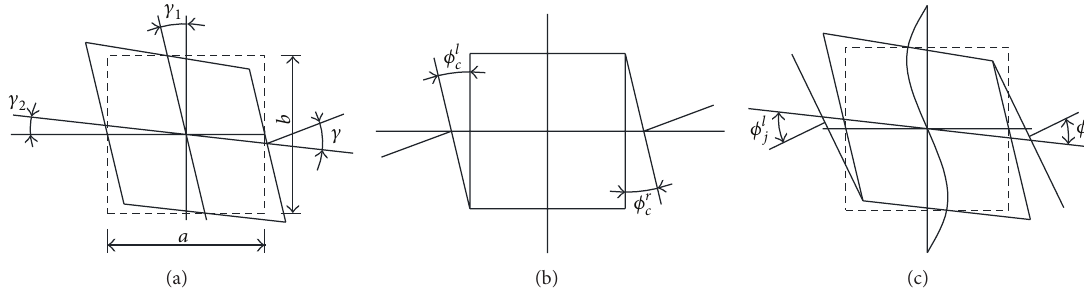
Figure 10: Definition of rotations at boundary of panel zone: (a) panel zone; (b) connection; (c) total joint.